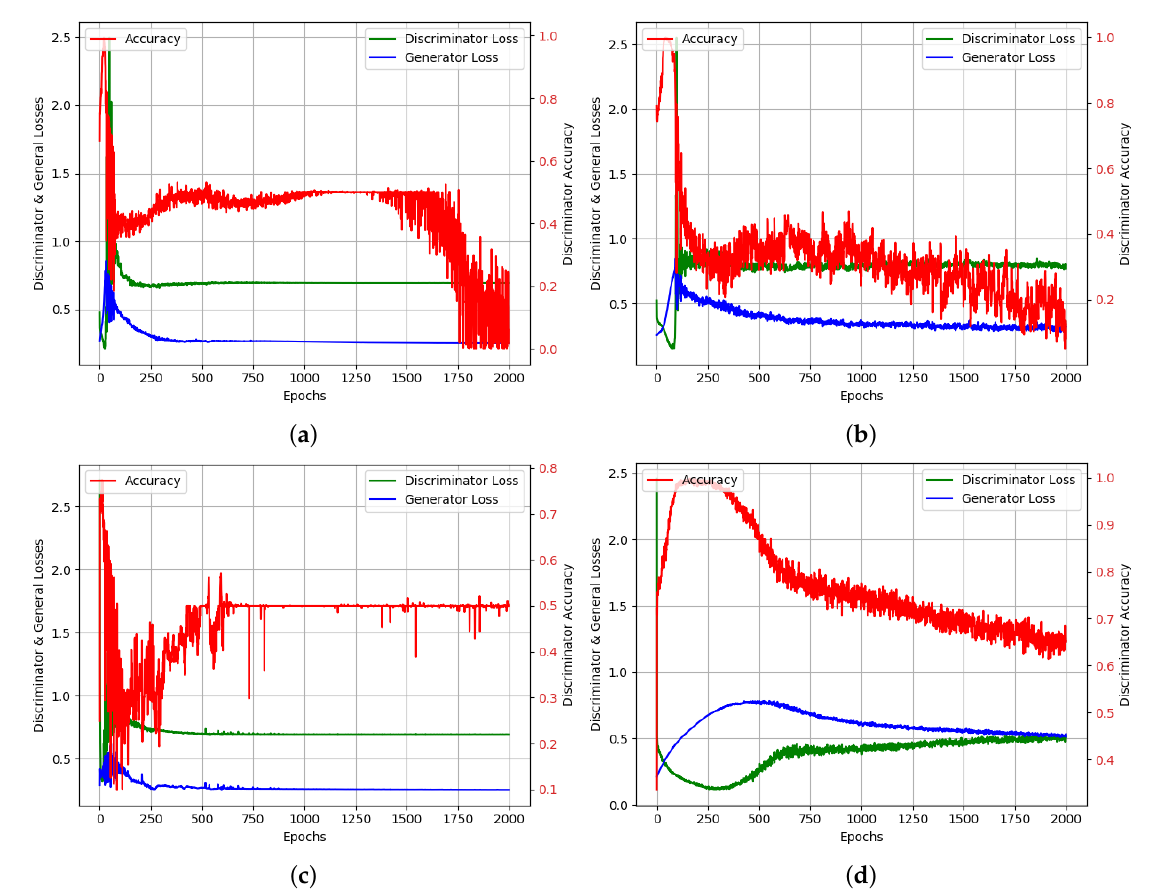
Figure 14. GAN test results for time series forecasting task loss and accuracy for Discriminator and Generator, ( a ) ‘adadelta’, ( b ) ‘adam’, ( c ) ‘rmsprop’, ( d )